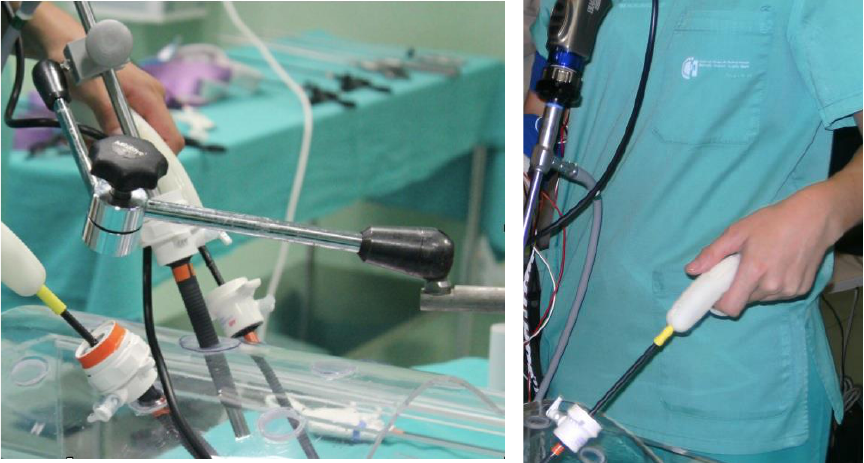
Figure 7. Prototype custom handle used in a simulation test.